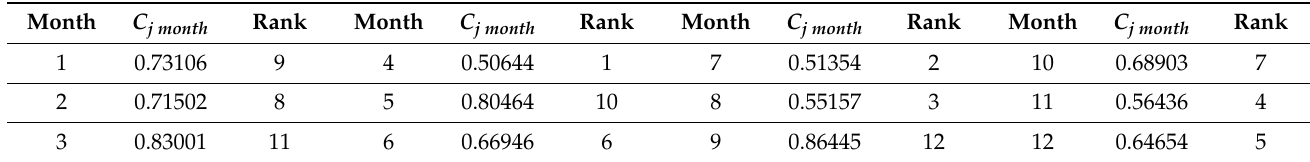
Table 7. Values and ranking of monthly systematic risk